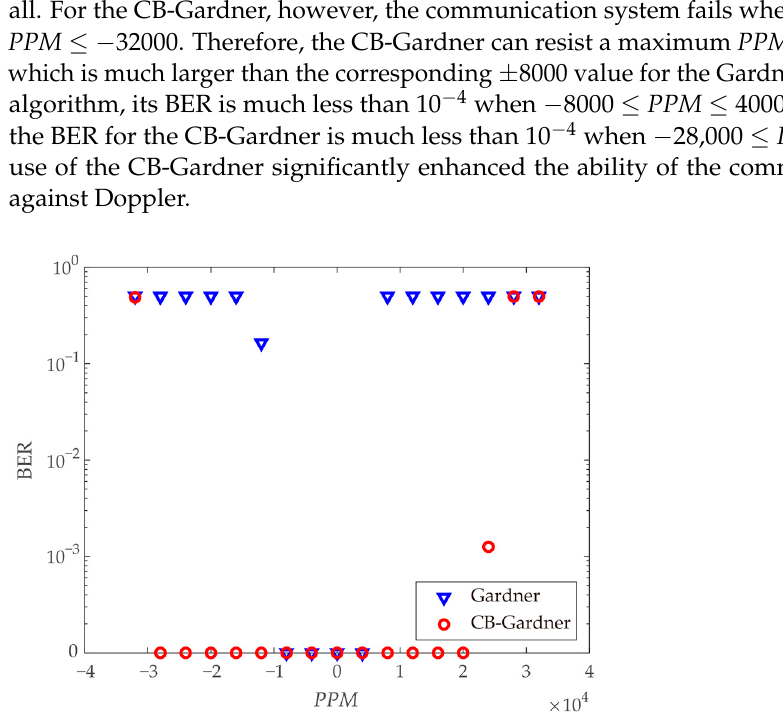
Figure 8. BER for di ff erent PPM with Gardner and CB-Gardner algorithm, SNR = 25 dB.